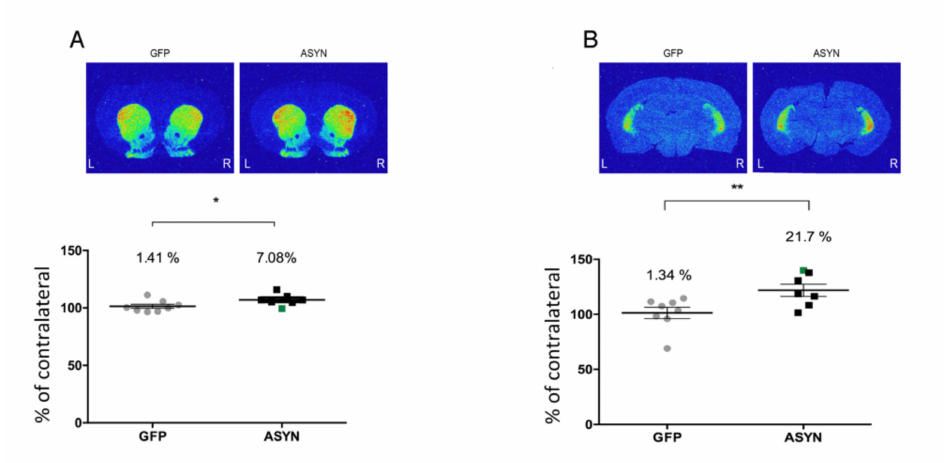
Figure 6. Representative autoradiograms of [ 3 H]raclopride binding to D2/3 receptors in the ( A ) rostral and ( B ) caudal striatum. Graphs at the bottom of each panel show the ipsilateral value as percentage of the contralateral binding. The green square represents the animal with lateral ASYN expression in the striatum. GFP ( n = 8), ASYN ( n = 7). Data are mean ± SEM, * p < 0.05, ** p < 0.01 (unpaired t-tests). Distance from bregma 1.20 mm and − 2.80 mm in ( A , B ), respectively.